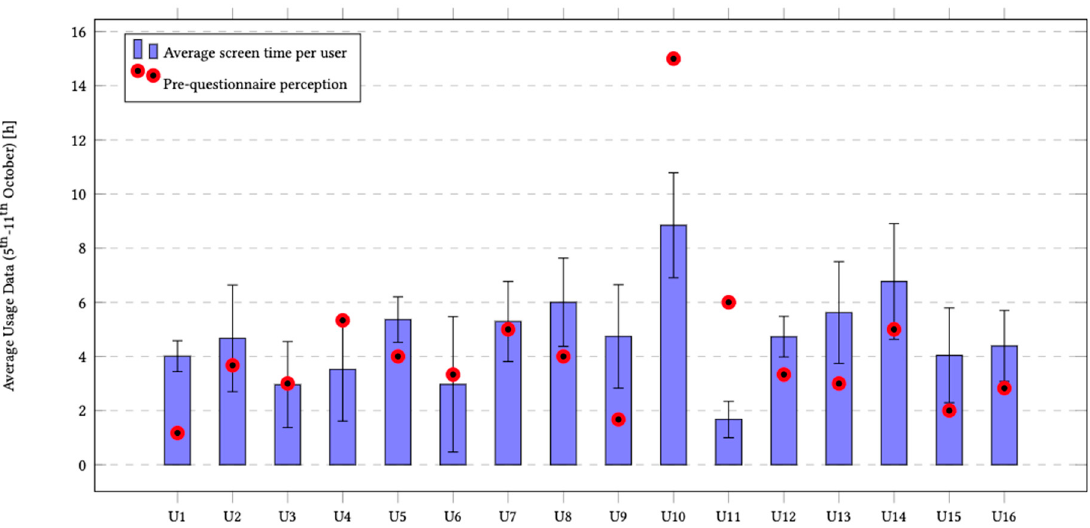
Figure 6. Average usage data, for each user, filtered by day, compared with their perception after filling the pre-questionnaire.